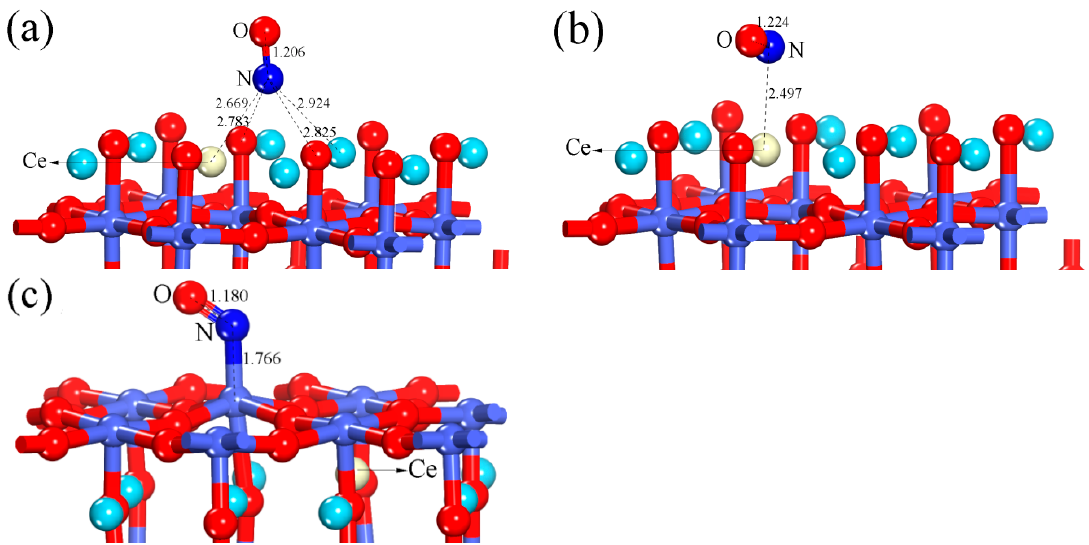
Figure 9. The optimized ( a ) hollow-NO and ( b ) Ce-NO configurations of the Ce-doped LaO-terminated LaCoO 3 (011) surface; the optimized ( c ) Co-NO configuration of the Ce-doped CoO 2 -terminated LaCoO 3 (011) surface.